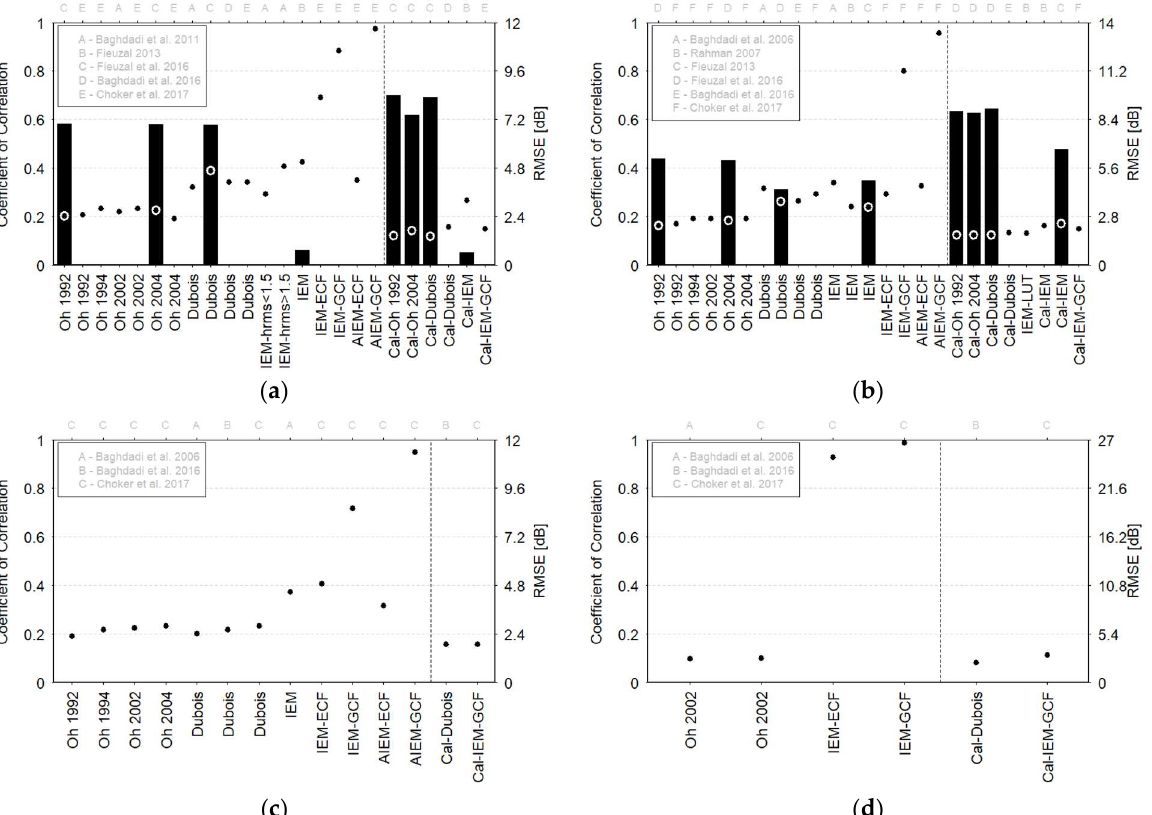
Figure 9. Statistical performance: RMSE (dots) and correlations (bars) obtained in previous studies by comparing the modeled and satellite-derived backscattering coefficients in the X-band in the HH polarization state ( a ) and in the C-band in HH, VV and VH polarizations states ( b – d , respectively). In each figure, the vertical dotted line distinguishes the original models (on the left) from the modified versions of the models (on the right) [24,29,30,60–63].